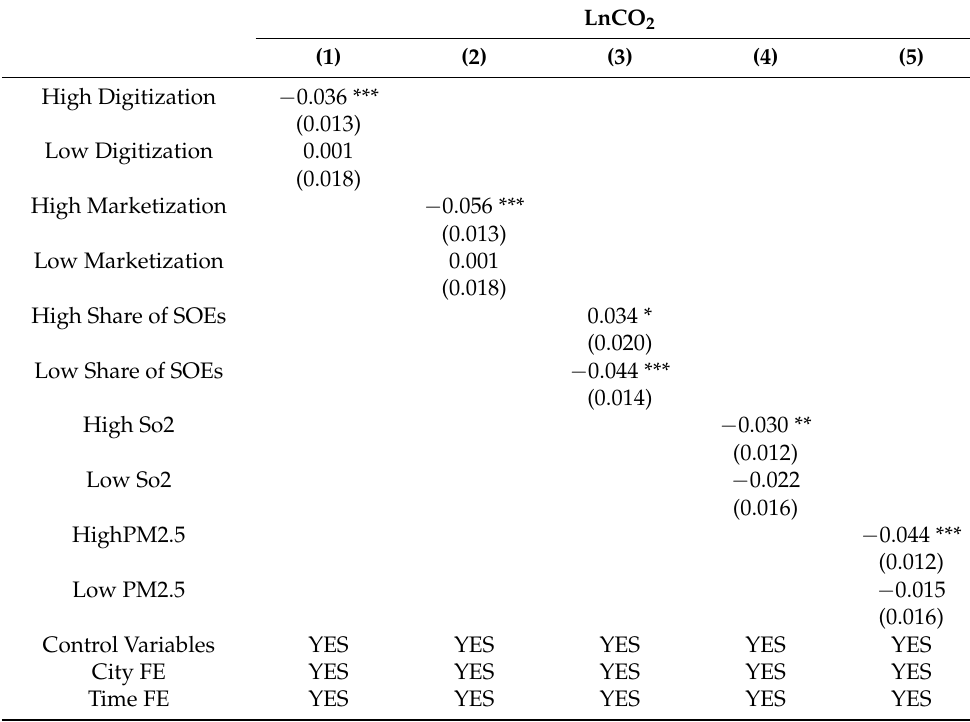
tested synergistic effects using a moderation-effect model are shown in Table 14. It indicates that high digitization and marketization are conducive to the CO 2 decrease effects of LCCP. LCCP has a strong synergistic effect on CO 2 decrease and pollution reduction. Table 13. Heterogeneity of urban characteristics.